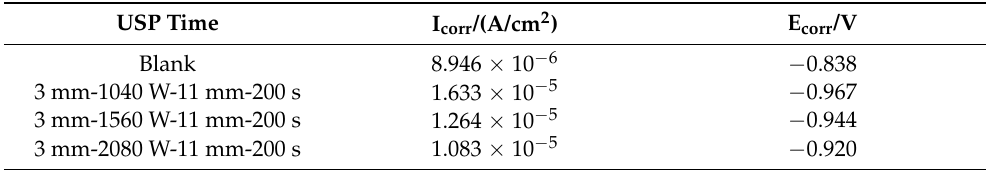
Table 6. The parameters of the equivalent elements in the equivalent circuit of the samples with different levels of USP power.